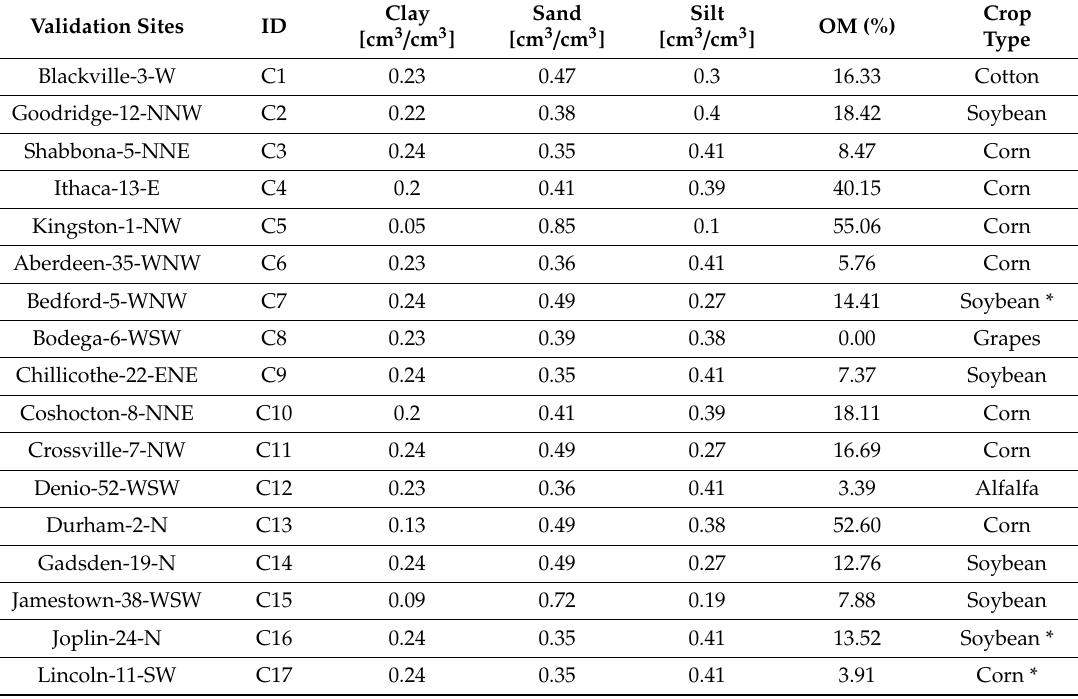
Table A2. Data used for validation over